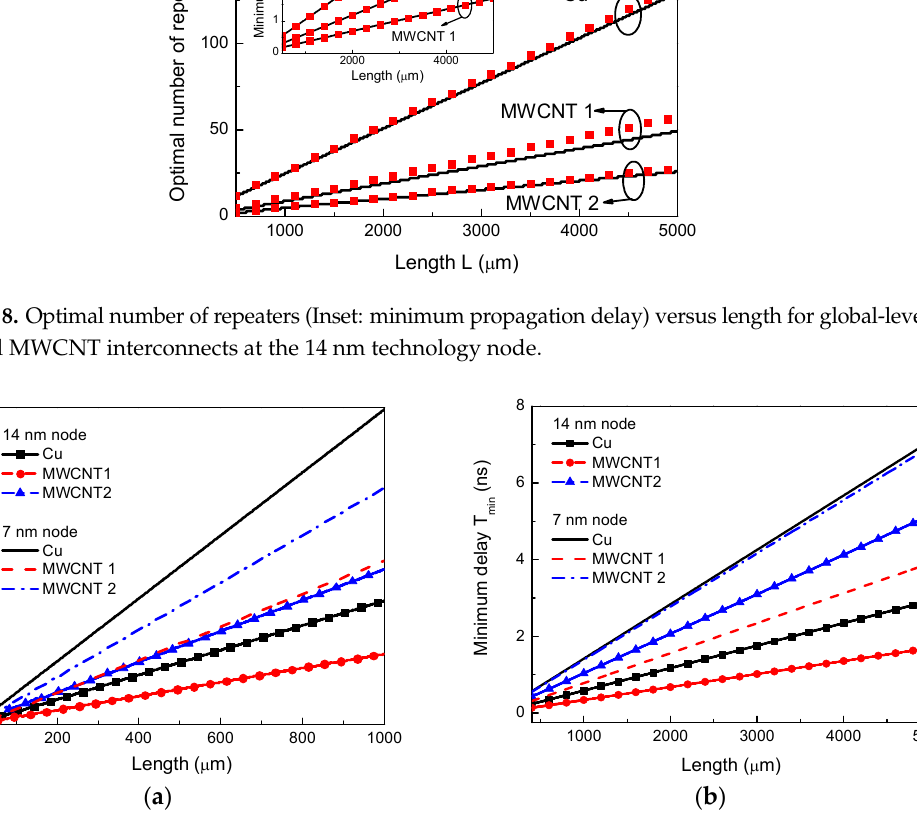
Figure 9. Minimum propagation delays versus length for ( a ) intermediate ‐ and ( b ) global ‐ level Cu and MWCNT interconnects.